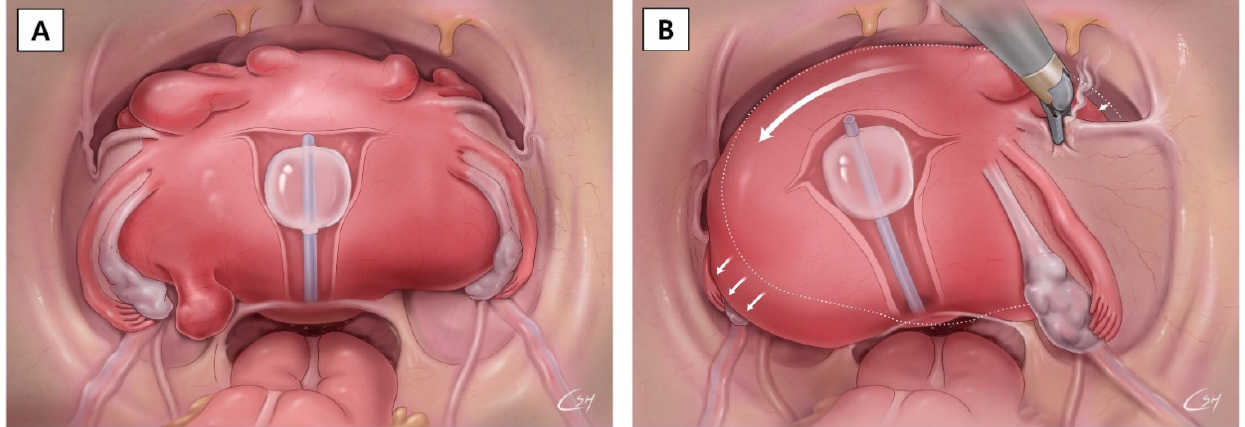
Figure 3. Single-site robot-assisted hysterectomy for massive mass removal. ( A ) The massive fibroid uterus fills the abdominal cavity. ( B ) Careful coagulation of round ligament using the bipolar grasper by rotation.